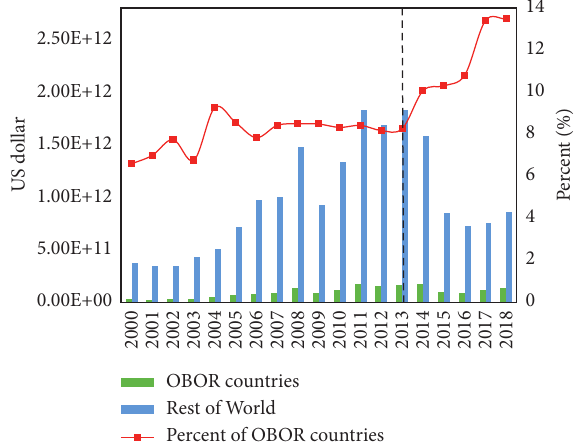
Figure 4: Changes in volume and share of fossil energy trade under OBOR since